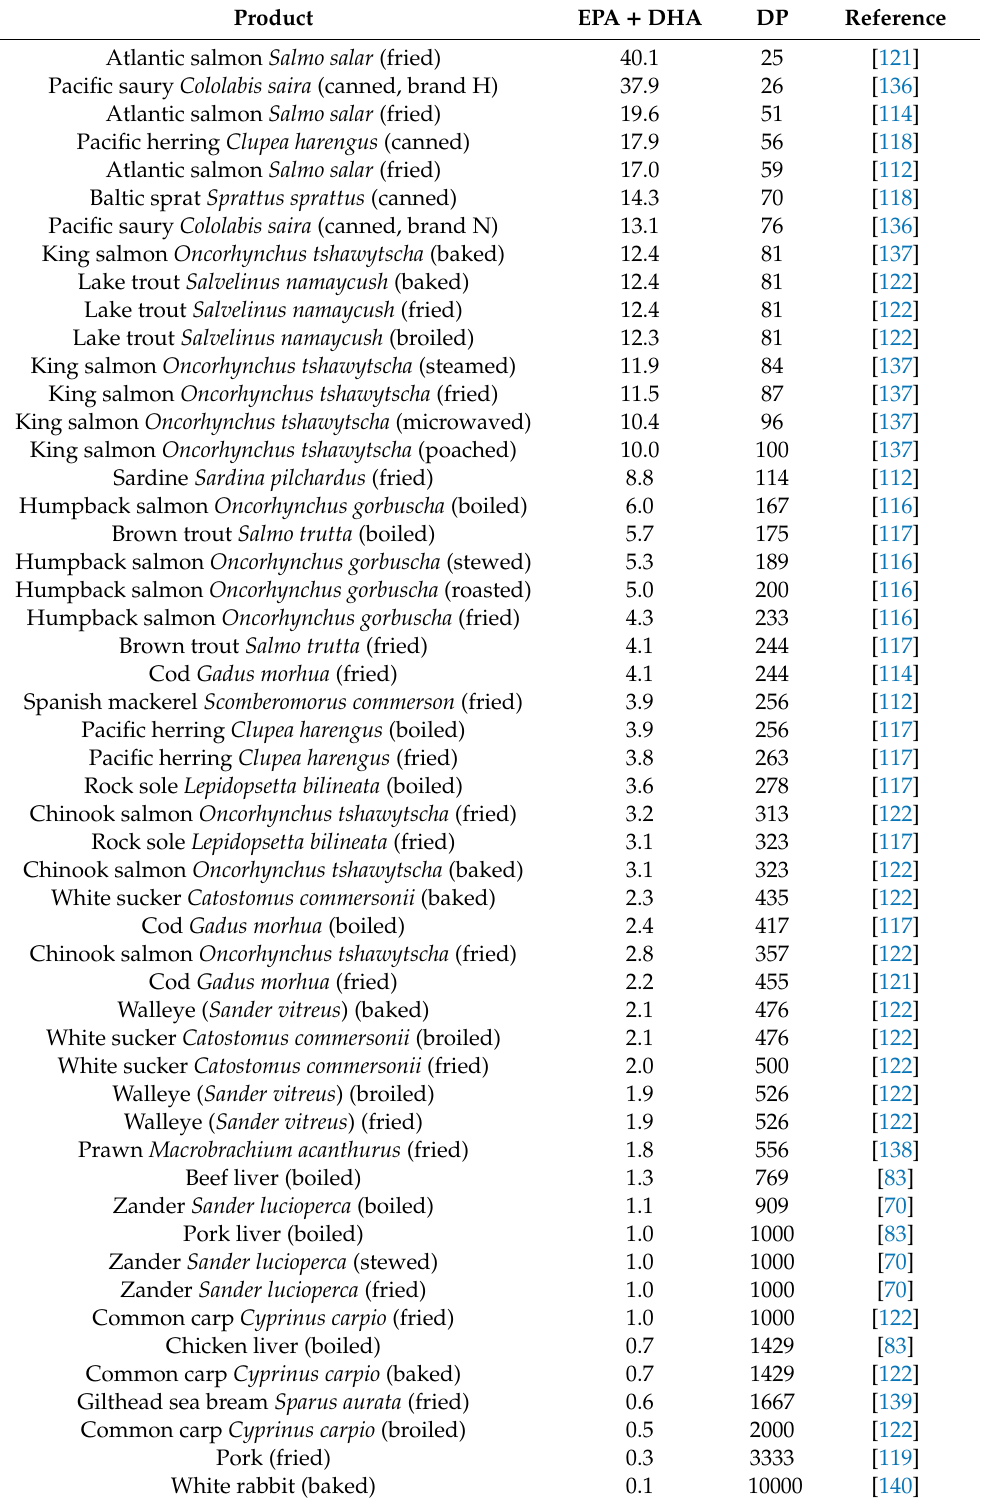
Table 1. Contents of the sum of eicosapentaenoic and docosahexaenoic fatty acids (EPA + DHA, mg g − 1 of product) in cooked fish and the daily portion of products (DP, g) that need to be consumed to obtain the recommended intake of EPA + DHA for humans, 1 g day − 1